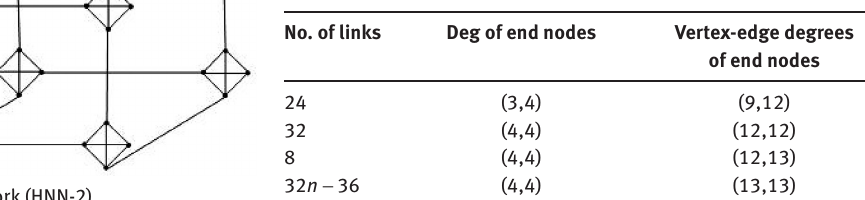
Table 6: The vertex-edge degree of the end nodes of links of − ( 2) HHN × n n